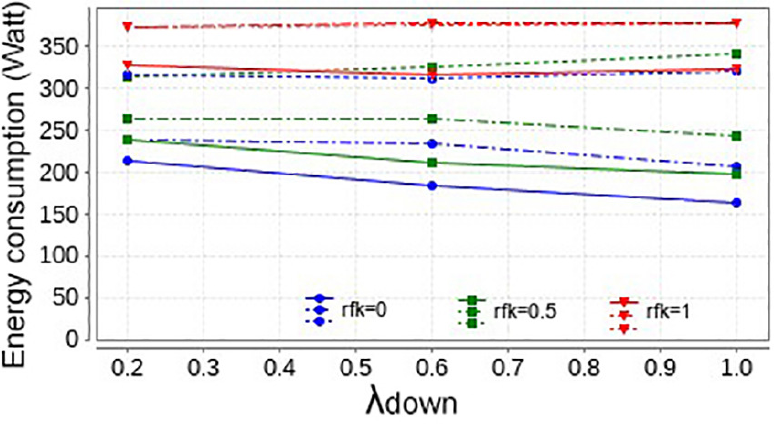
Figure 6. Energy consumption consequences of a MITM attack: mechanism proposed in [21] (dotted line), wake-up mechanism (dashed line), both wake-up and time-out mechanisms (solid